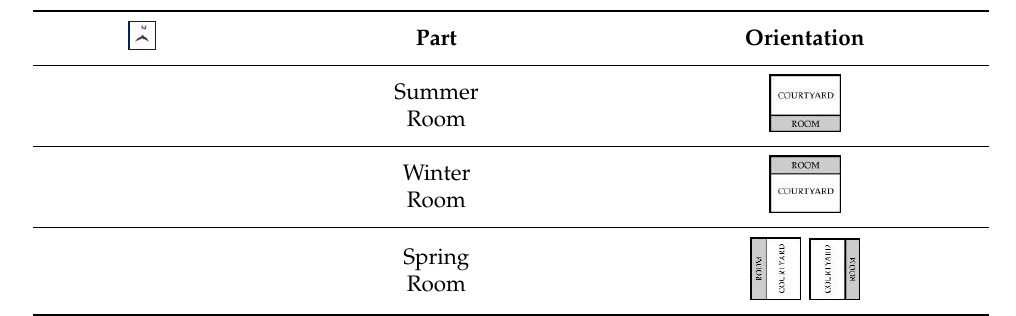
Table 3. The positioning of the seasonal spaces [41].